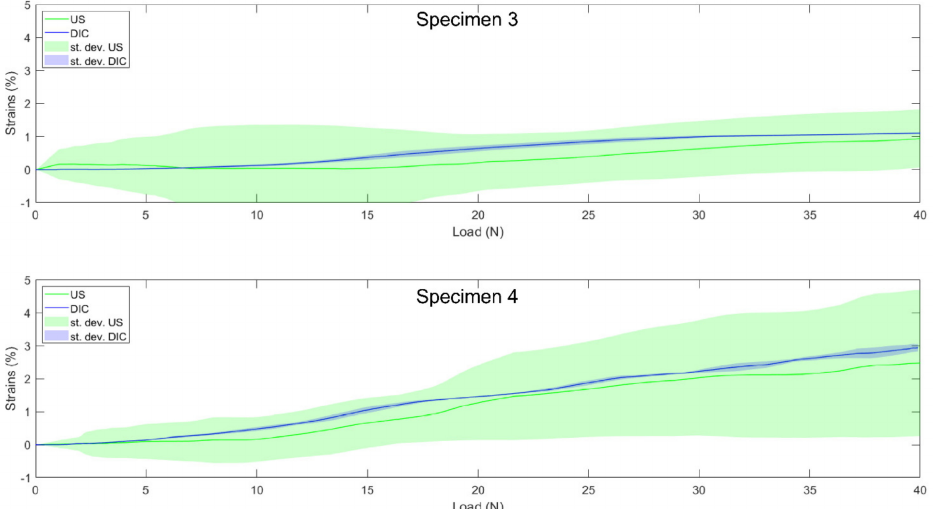
Figure 8. Individual load–strain curves for the two valid medial collateral ligaments from the “validation” group from 0 to 40 N. Solid lines represent the US (the green) and DIC (blue) load–strain curves. Shaded areas represent standard deviation across the trials of each specimen for US (green) and DIC